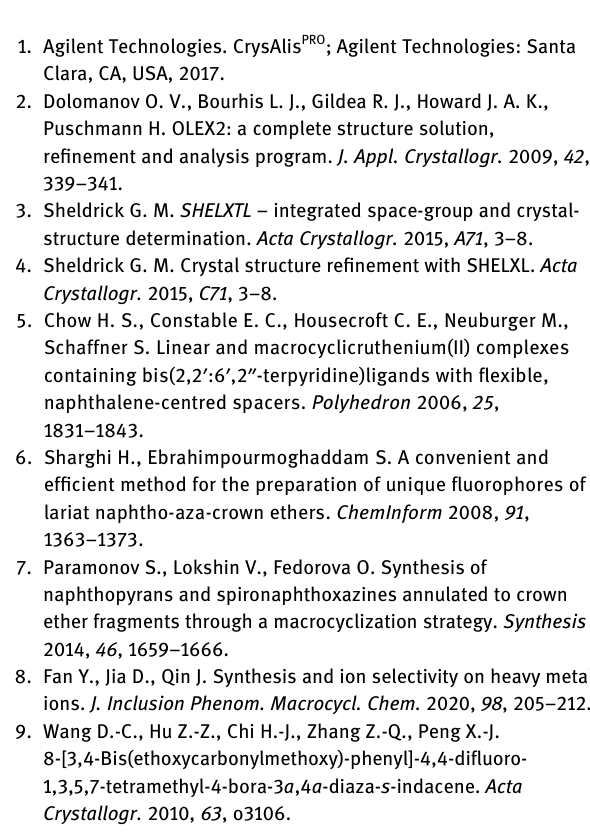
The crystal structure clearly indicated the chemical structure and configuration of diethyl-2,2-(naphthalene- 2,3-diylbis(oxy))diacetate, and all the intramolecular bond lengths and angles are in the expected ranges. The Cambridge Structural Database was searched and five structural related compounds were found [9 – 11]. By comparison with these compounds, it was observed that the title compound contains a unique naphthalene ring as the center core, which causes one of the two ester side chains to be coplanar with the naphthalene ring, while in the other compounds, both ester side chains are located on the same side of the aryl moiety.